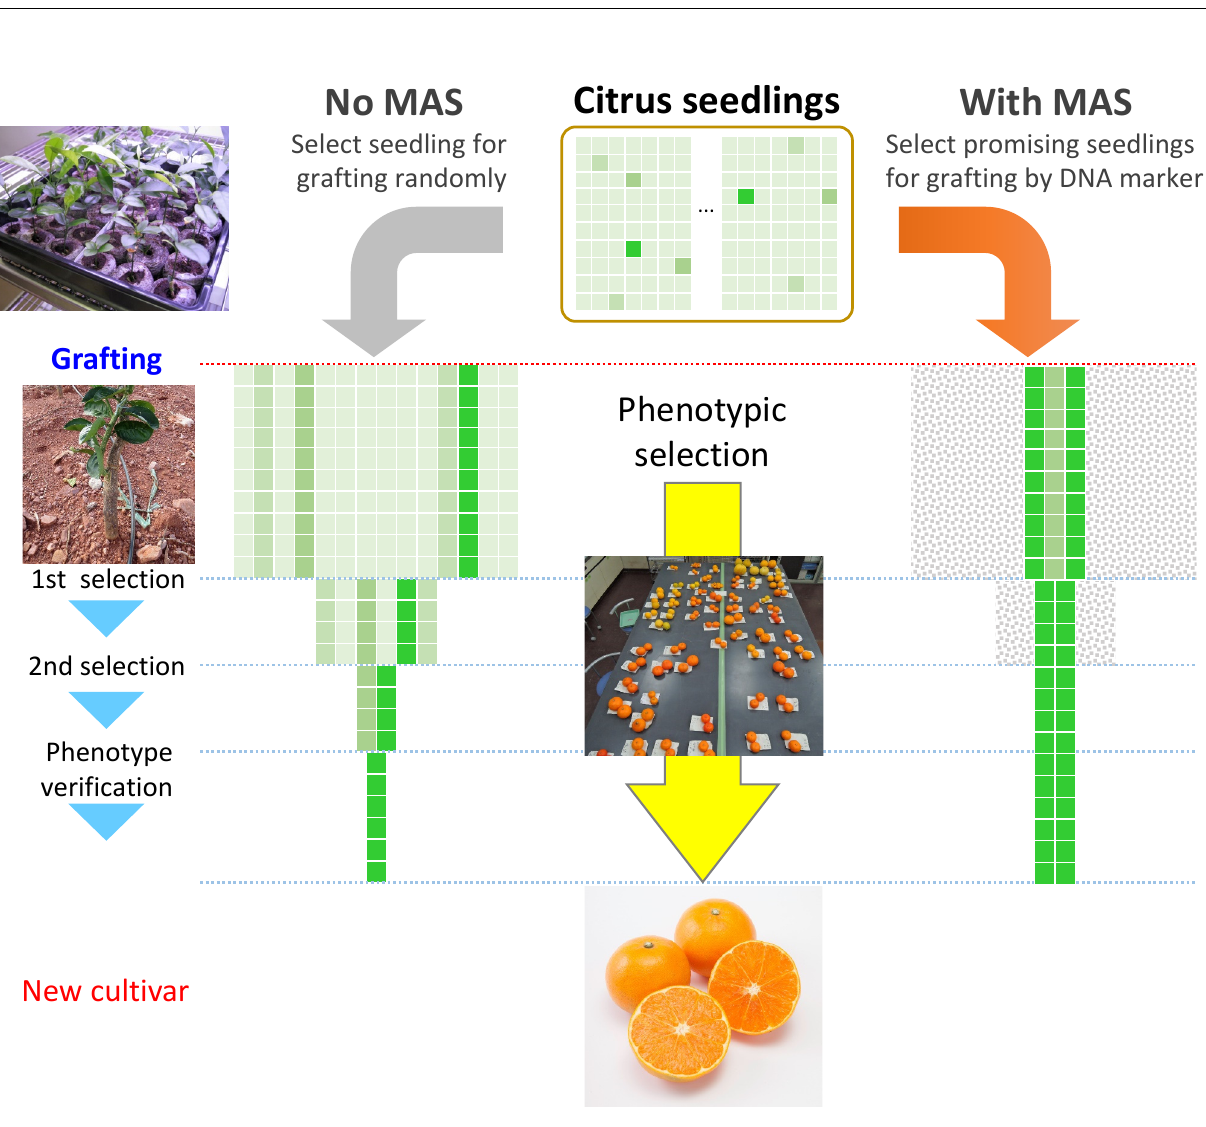
Figure 2. Scheme of how marker-assisted selection (MAS) works for improving breeding efficiency. Each square represents a seedling. A vivid green square corresponds to a promising seedling, and a pale one represents a seedling to be discarded. Conventional breeding that does not use MAS (left) selects citrus seedlings randomly then grafts them at the orchard; thus, the occurrence of elite hybrids is low. The breeding with MAS (right) selects candidate seedlings, then grafts the candidate seedlings, and presents a higher chance for selection of promising candidates than conventional